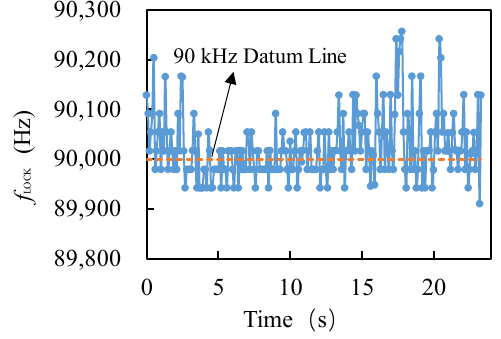
Figure 4. Variation of f LOCK over